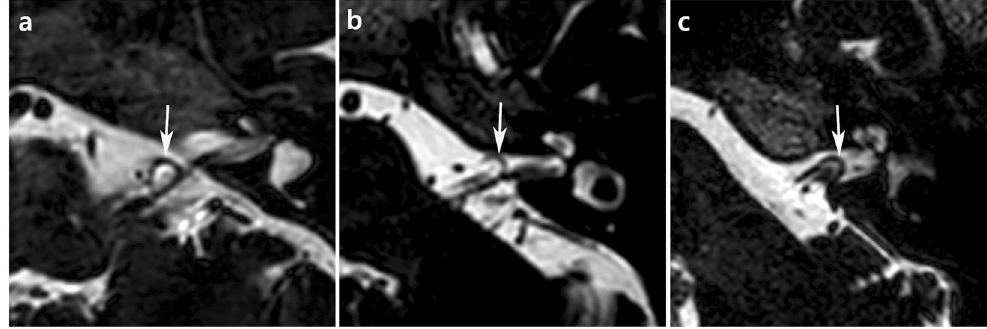
Figure 1. The types of AICA loops. ( a ) Type I loop is lying within the CPA (arrow) but not entering the IAC. ( b ) Type II loop is entering the IAC (arrow) within < 50% of the length of the IAC. ( c ) Type III loop is extending into more than 50% of the IAC